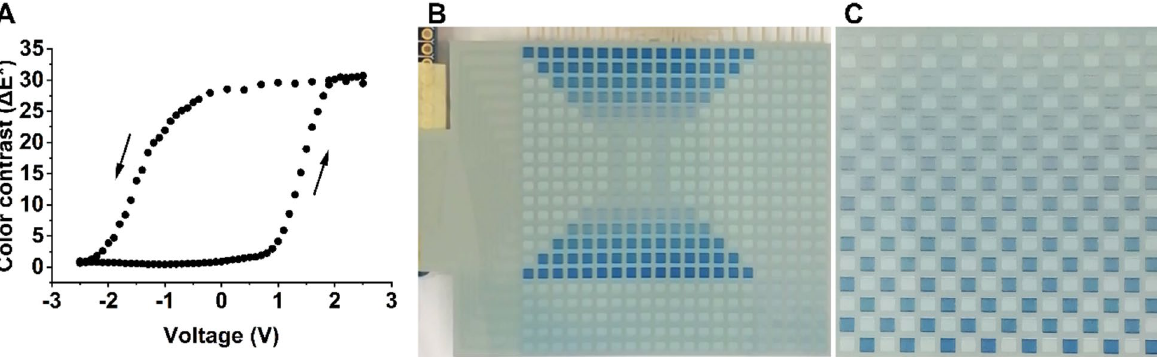
Figure 2. The color contrast (ΔE*) vs. voltage hysteresis enables arbitrary grayscale images in screen printed PMADs. ( A ) The graph shows that the desired hysteresis is obtained also when investigating the color contrast (ΔE*) vs. voltage. Upon exceeding the onset of the respective electrochromic switching event (1 V in the forward direction and -0.5 V in the reverse direction), the coloration scales almost linearly with the applied voltage, which in turn allows for the presentation of PMAD images with different grayscale levels. ( B ) The photograph shows a PMAD updated into an image resembling the shape of an hourglass. Besides the pixel addressability, eight different grayscale levels are also demonstrated in this image. ( C ) The photograph shows when the same PMAD instead is updated into a 16 × 16 chessboard pattern. Besides the ability to update the pixels of the PMAD without any discernable cross-talk effects, thereby allowing for the update of any kind of pattern in these screen printed electrochromic displays through passive matrix addressing protocols, 17 grayscale levels are also demonstrated by subsequently increasing the voltage amplitude in the row by row update sequence of the Videos S1 and S2 indicate that the pixel switching time is shorter than 50 ms, since the reduction and oxidation pulses provided by the 10 Hz square wave signal are sufficiently long to fully switch the pixels between their two coloration states. The initial I vs. V behavior, as well as after 10 2 , 10 3 , 10 4 and 10 5 switching cycles, are shown in Fig. 1B. All of the tested pixels were functional after 10 5 switching cycles, even though minor degradation could voltage amplitudes can be used in the passive matrix addressing protocol throughout the operational lifetime of the PMAD. Arbitrary grayscale PMAD images enabled by the color contrast versus voltage characteris- tics.